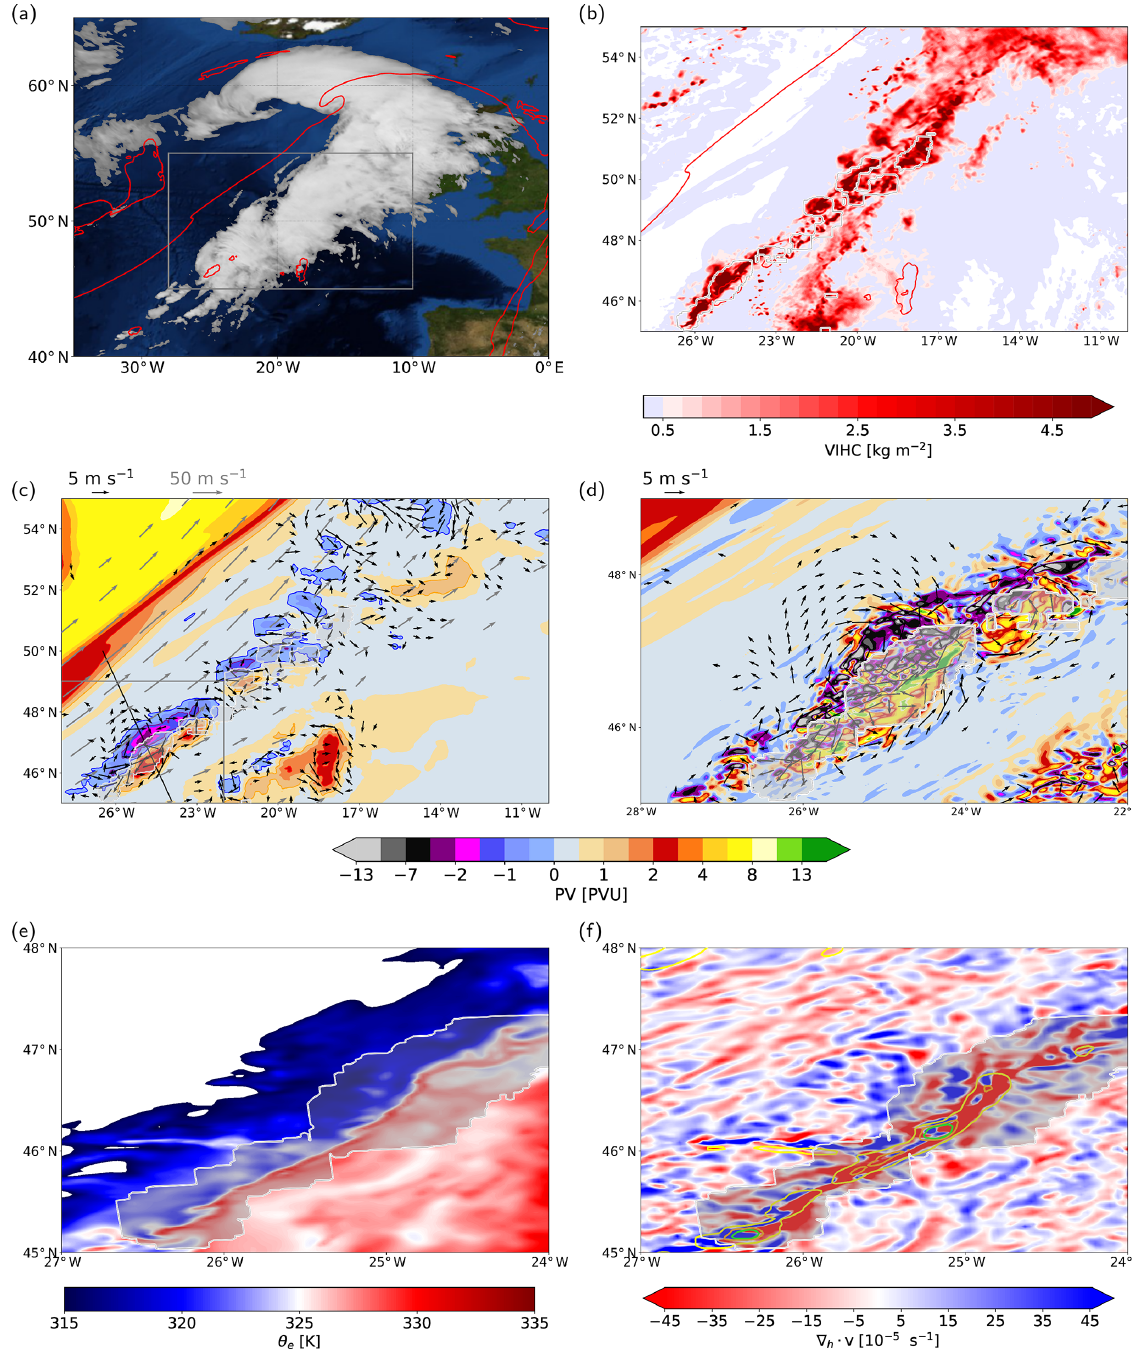
Figure 9. Example of embedded convection in the WCB at 09:00UTC, 23 September 2016. (a) Pseudo-IR satellite image of the large- scale cloud structure (data from 10.8µm channel, EUMETSAT, Schmetz et al., 2002) and 2PVU contour at 320K (red line). (b) Vertically integrated hydrometeor content (VIHC, in kgm − 2 , colors for VIHC > 5gm − 2 ) for the region outlined in (a) (grey box), envelope of rapid WCB ascent (white outline, WCB trajectory ascent > 320hPa in 2h), and 2PVU contour at 320K (red line). (c) Coarse-grained PV at 320K (colors, in PVU; purple, blue, orange, and red contour lines show − 1, 0, 1, and 2PVU; see text for details), 2h circulation anomalies at 320K (black arrows), wind speed at 320K (grey arrows), and envelope of rapid WCB ascent (white outline). (d) Enlargement of embedded convection shown in (c) (grey box) with PV at 320K from the original 2km model grid, 2h circulation anomalies at 320K (black arrows), and envelope of rapid WCB ascent (white outline). (e) Enlargement of embedded convection shown in (c) with equivalent potential temperature at 900hPa ( θ e , in K) and envelope for rapid WCB ascent (white outline). (f) The same as (e) but for low-level wind divergence at 295K (colors, in s − 1 ), PV (coarse-grained to 12km) at 295K (yellow, lime, and magenta contour lines at 2, 4, and 5PVU), and envelope of rapid WCB ascent (white